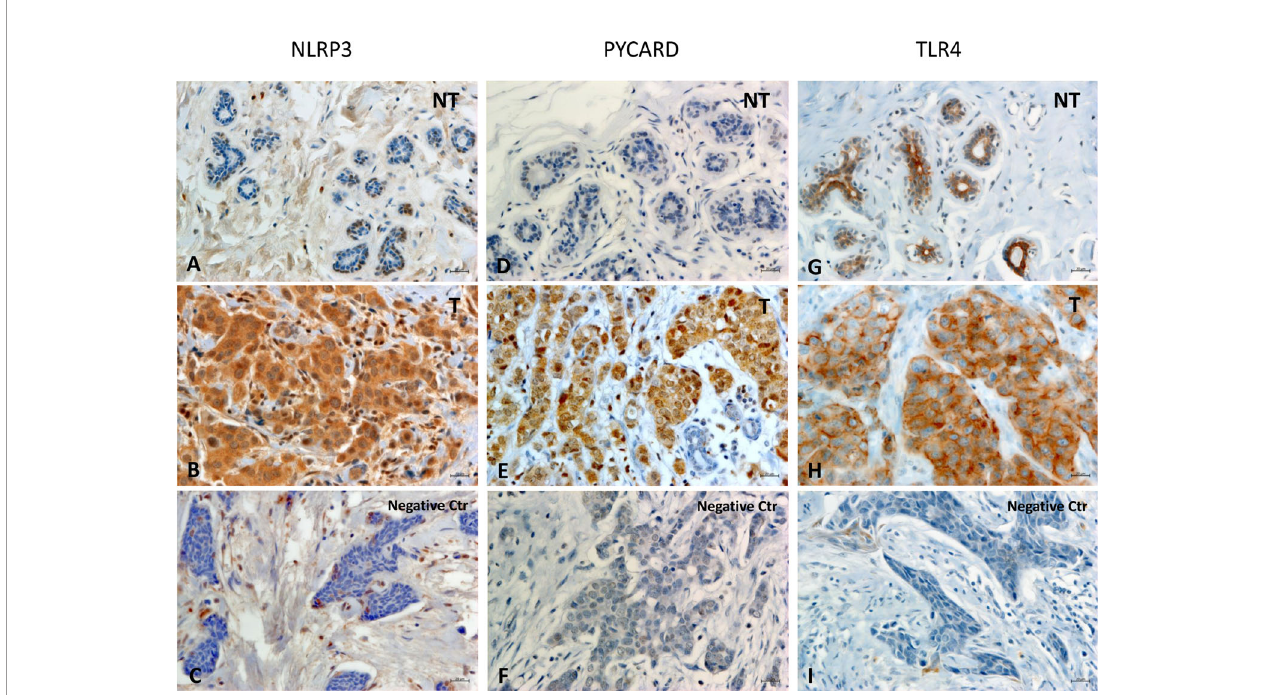
FIGURE 1 | Representative images of immunohistochemical staining in Breast Cancer tissues. The panel displays the representative expression of molecular biomarkers in different areas: (A) NOD-like receptor protein 3 (NLRP3) expression in Non Tumoral (NT) area; (B) NLRP3 expression in Tumoral (T) area; (C) negative control for NLRP3 expression; (D) Apoptosis-Associated Speck-Like Protein Containing a Pyrin and CARD domain (PYCARD) expression in NT area; (E) PYCARD expression in T area; (F) negative control for PYCARD expression; (G) Toll like receptor 4 (TLR4) expression in NT area; (H) TLR4 expression in T area; (I) negative control for TLR4 expression; (original magni fi cation, ×400). Scale bar = 20